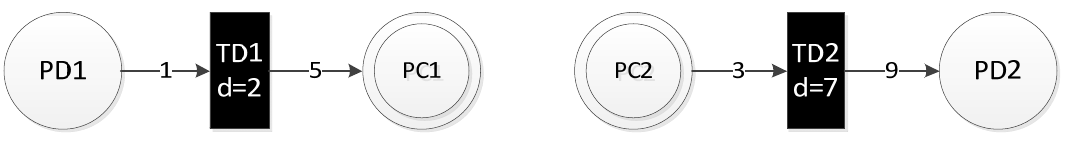
discrete(delay=2) is connected to a Transition (delay=7).